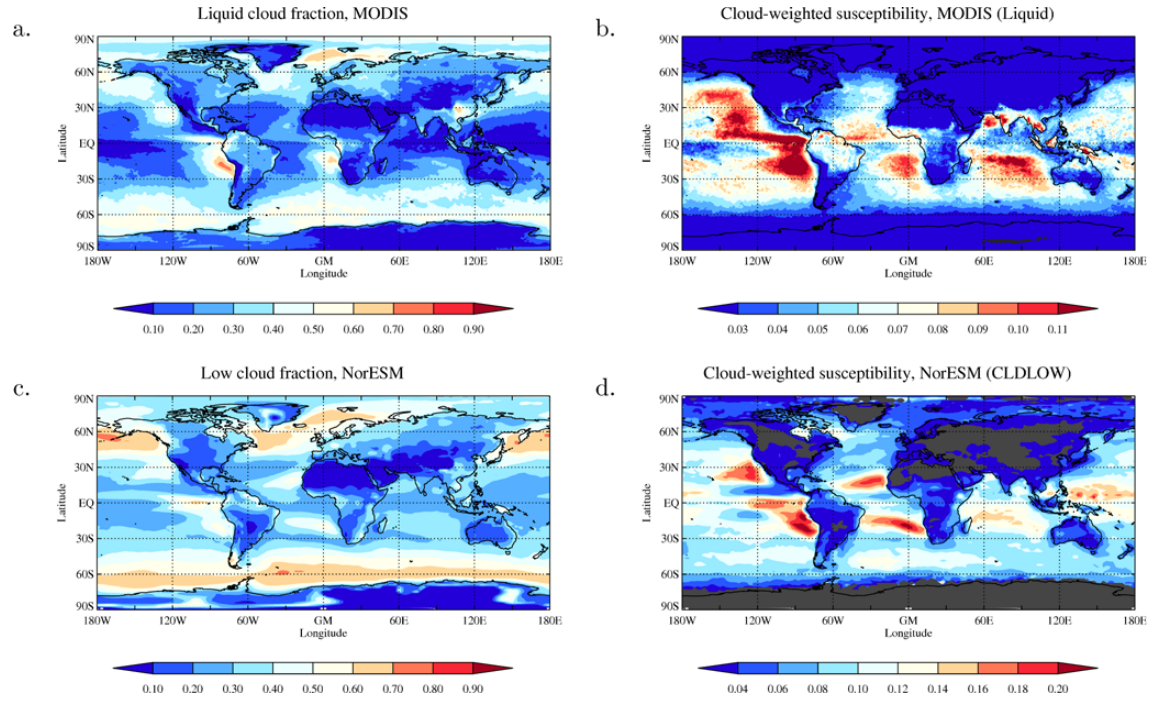
Fig. 2. (a) Liquid mean cloud fraction from MODIS data, (b) cloud-weighted susceptibility from MODIS data, (c) low cloud fraction from NorESM, (d) cloud-weighted susceptibility from NorESM simulations. All annual means. Please note that color bars differ.